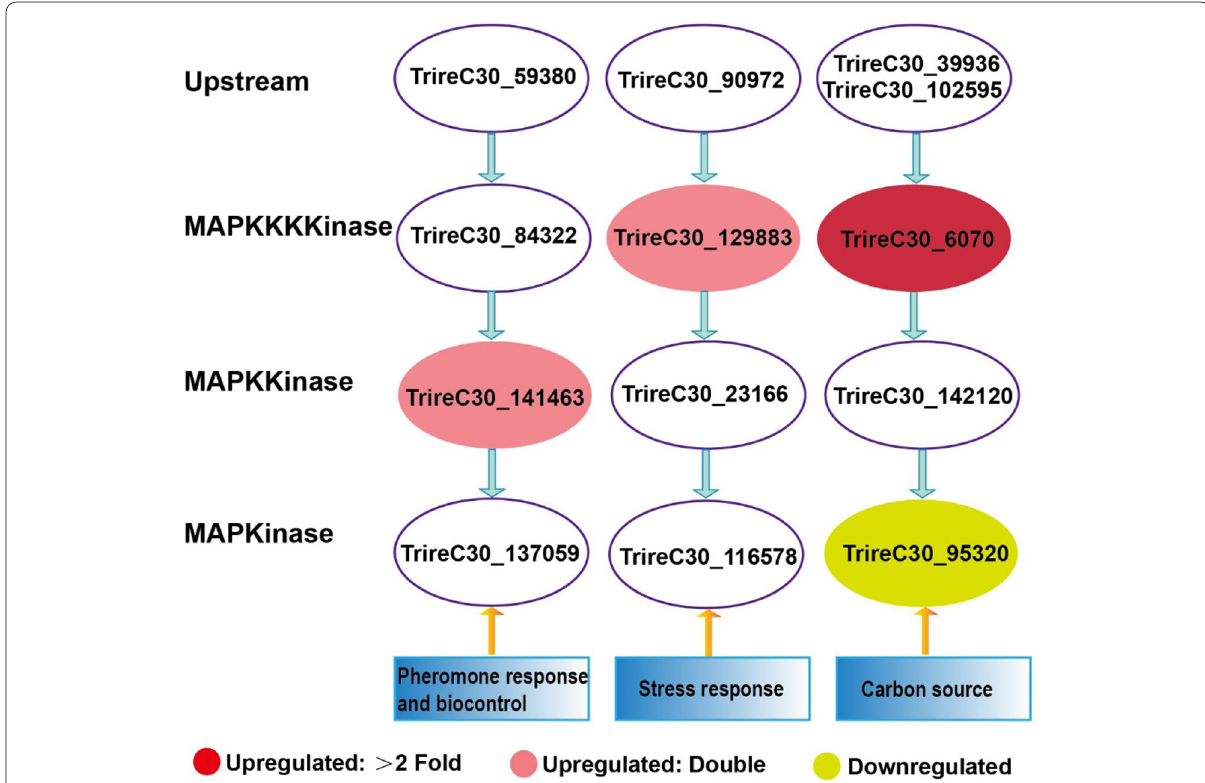
Fig. 5 Differential transcription of genes involved in the MAP kinase cascade pathway, as deduced from reported functions and interactions of the respective nearest neighbors in S. cerevisiae and other filamentous ascomycetes according to Schmoll